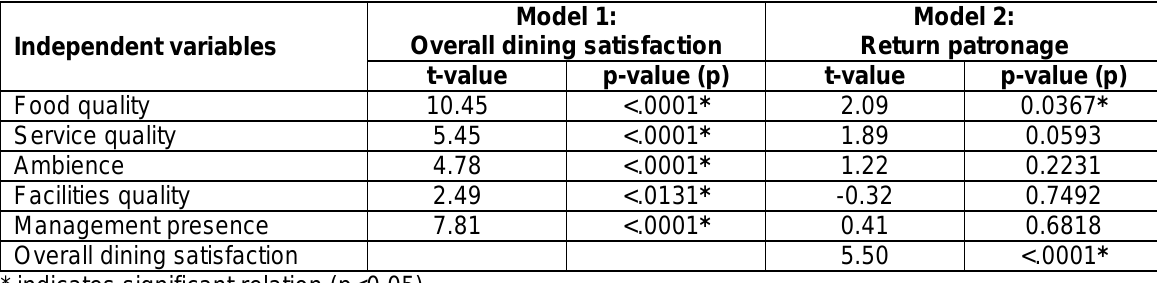
Table 3: Regression results of overall dining satisfaction and return patronage Model Independent variables